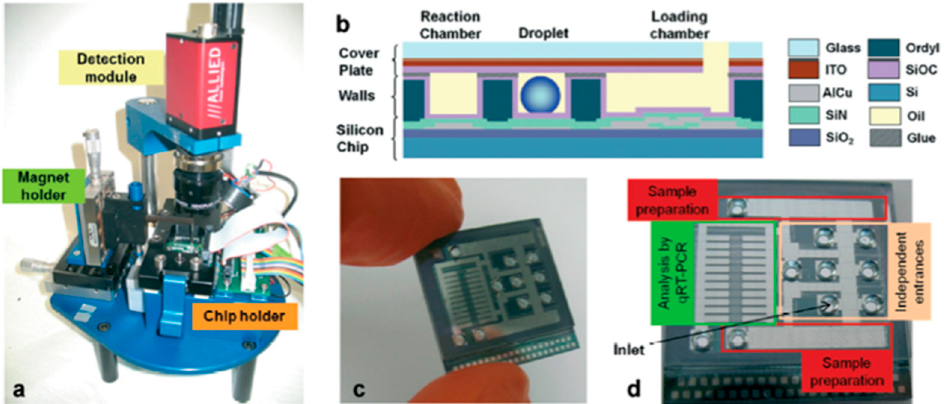
Figure 4. DMF device assembly: ( a ) Additional instrumentation for the DMF chip control; ( b ) Chip cross section, evidencing all the constituting layers; ( c , d ) Photographs of the actual DMF chip, showing the most relevant chip regions. Adapted from original in reference [24].